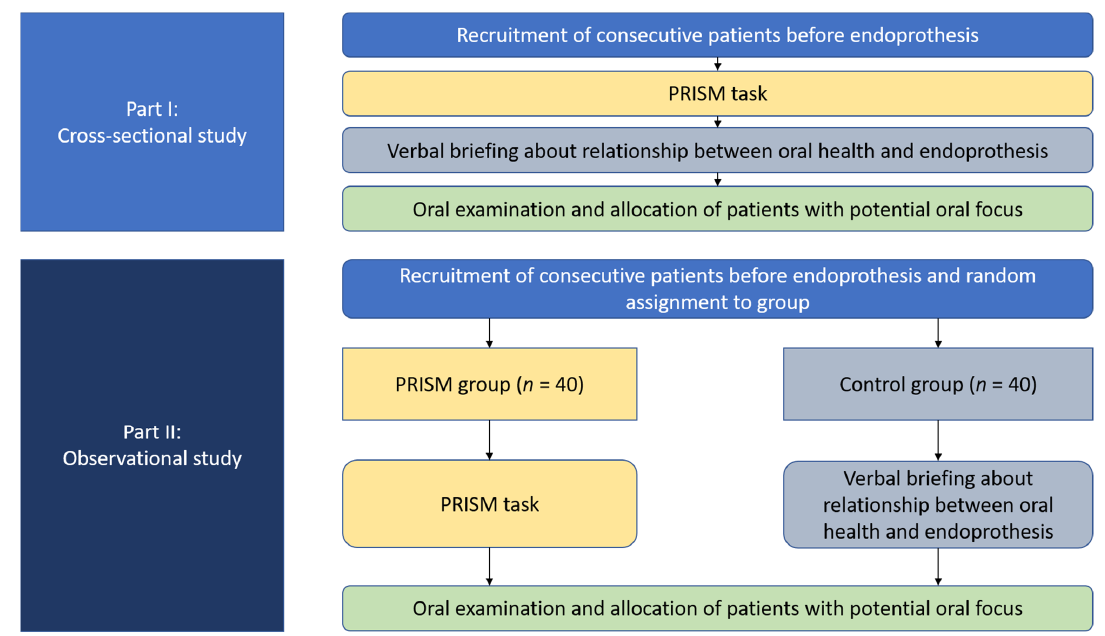
Figure 3. Study flow of both parts of the current investigation.